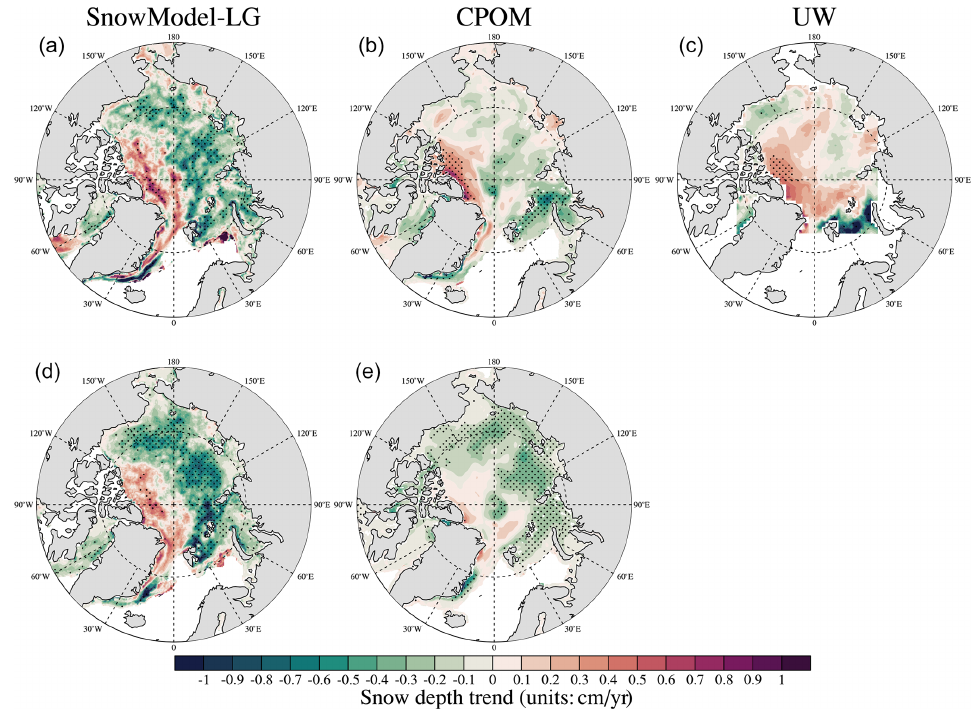
Figure 9. Trend of snow depth (units: cmyr − 1 ) for SnowModel-LG, CPOM and UW in spring (April) (a–c) and autumn (November) (d, e) during the period from 1991 to 2015. Areas with significant trends are shown as dotted areas (confidence level